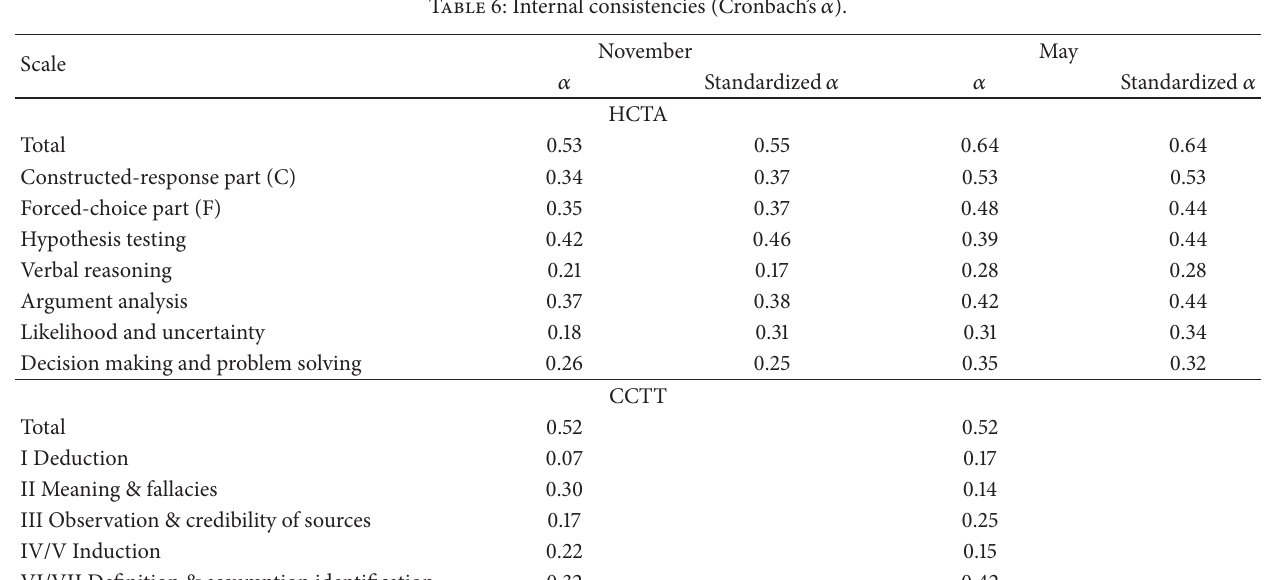
Table 6: Internal consistencies (Cronbach’s 𝛼 ).